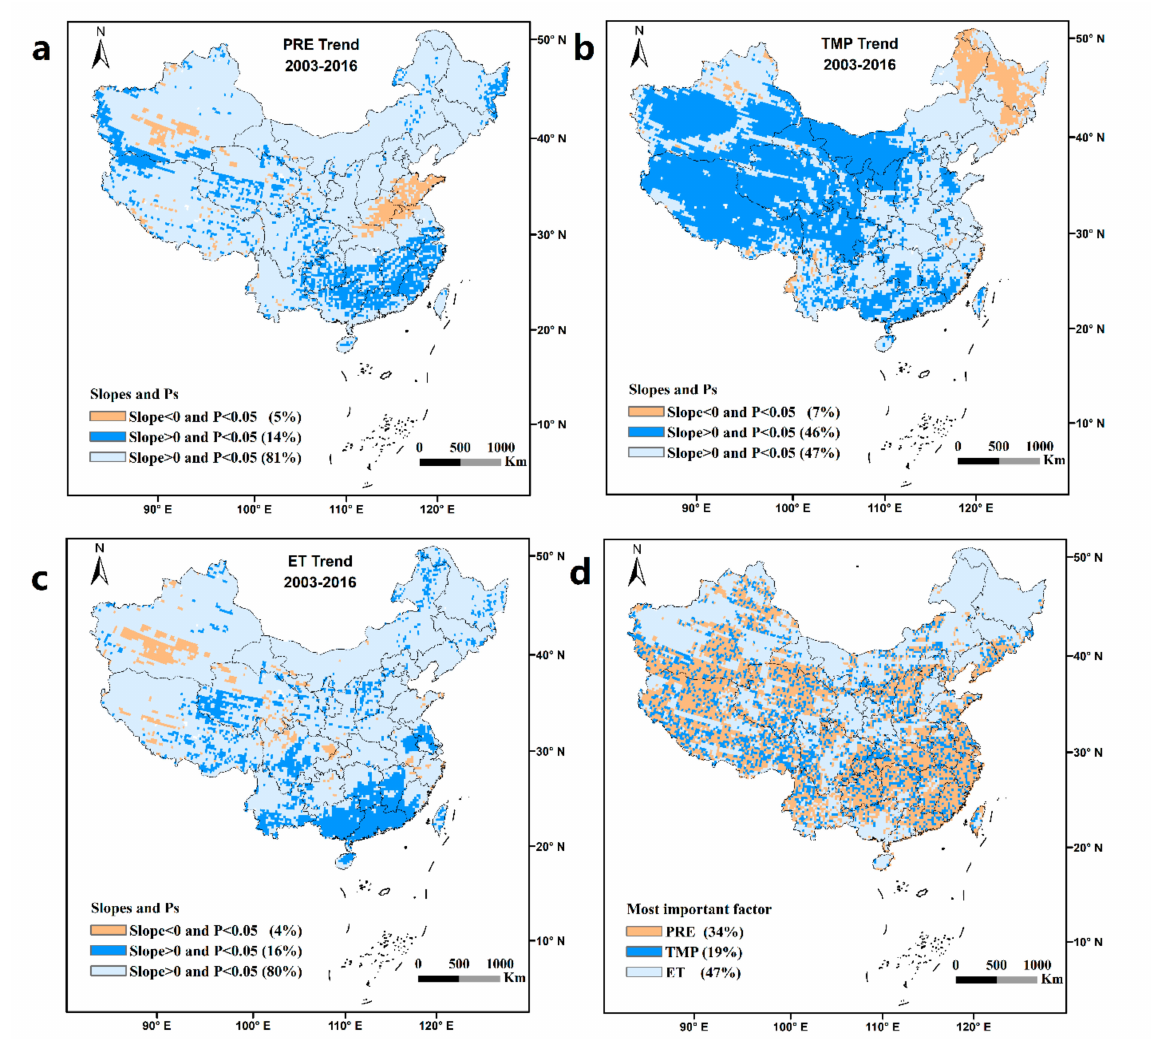
Figure 7. Spatial distribution pattern of the trends in environmental factor for the period 2003–2016. ( a ) Precipitation; ( b ) temperature; ( c ) evapotranspiration, ( d ) the most important environmental factor. Multiple linear regression was used to calculate the main environmental factors a ff ecting terrestrial water storage at the pixel